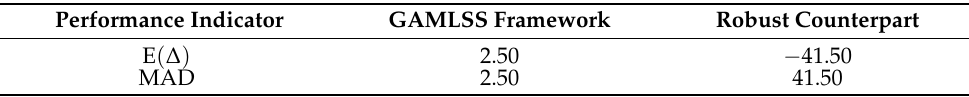
Table 15. Evaluation of out-of-sample scenarios for the case study according to the listed indicator. Performance